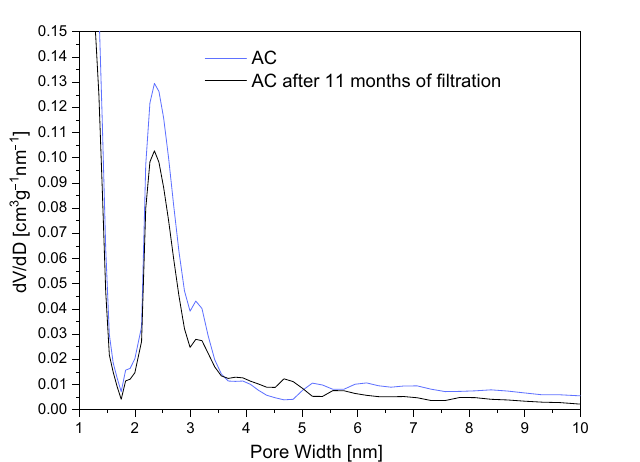
Figure 7. Pore-size distributions calculated for activated carbon before and after 11 months